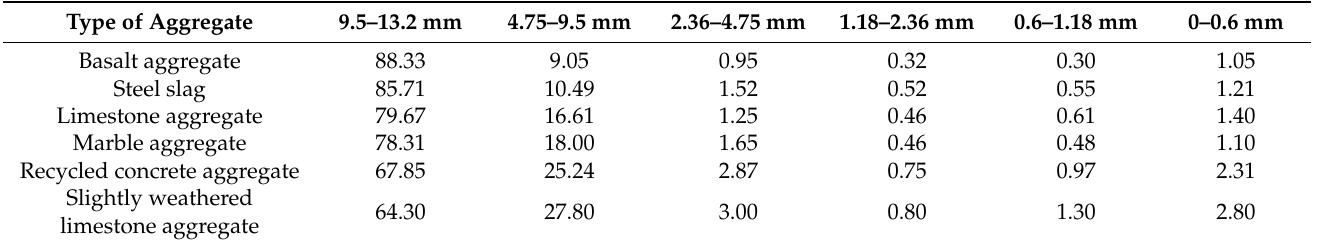
Table 11. Aggregate particle distribution after roller compaction.